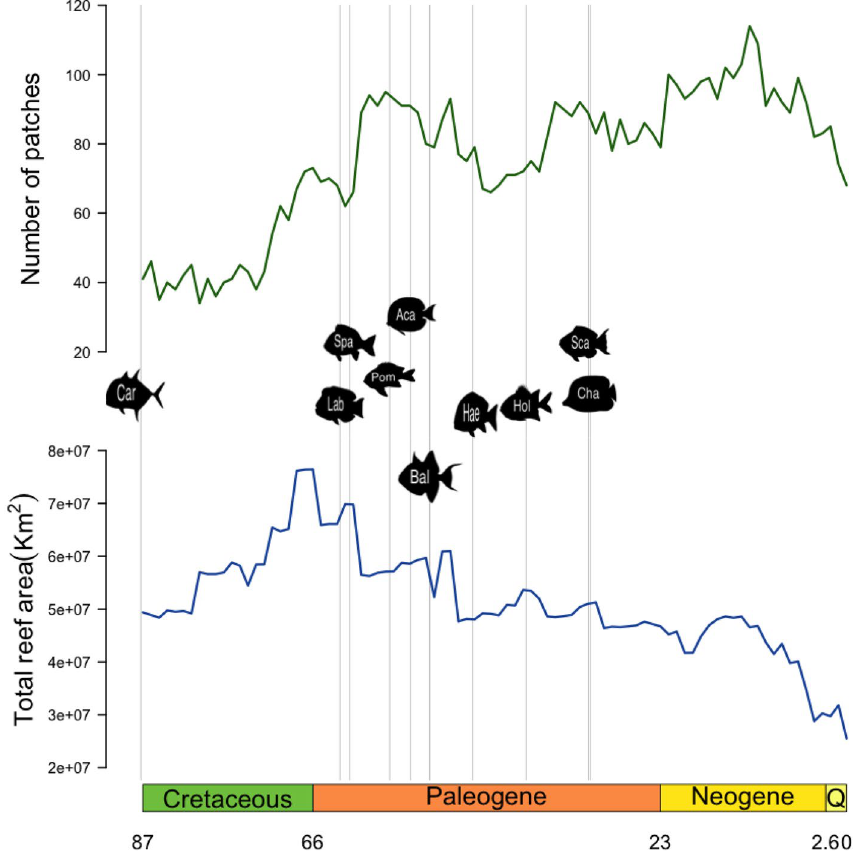
Figure 1. Variations in number of coral reef patches and total coral reef area through time. The grey lines correspond to the estimated crown age of the phylogenies included in the analyses. Aca Acanthuridae,